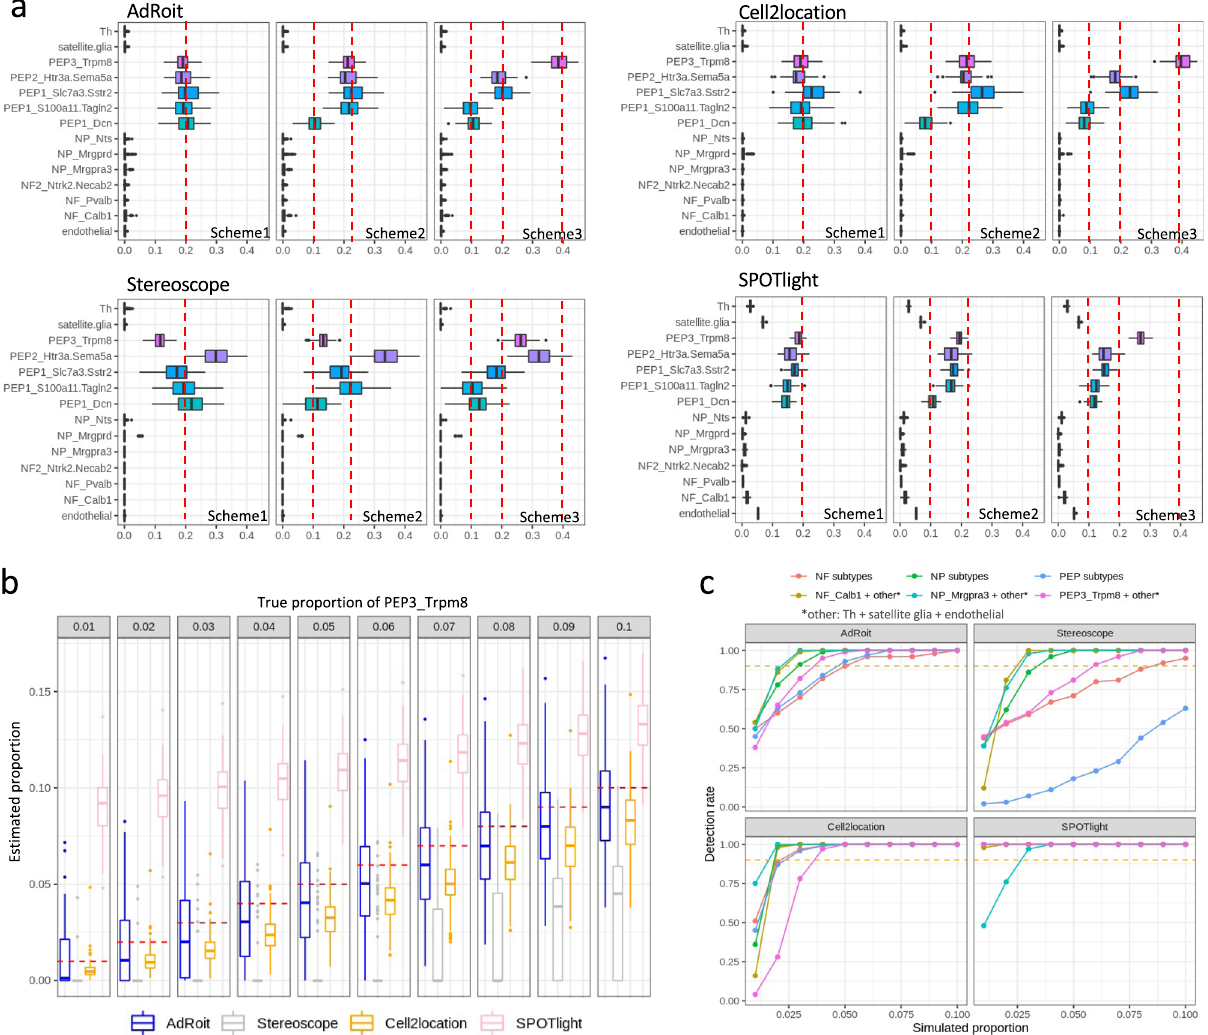
Fig. 5 AdRoit shows a good accuracy and sensitivity in deconvoluting spatial spots simulated from dorsal root ganglion cells. a Estimations from AdRoit, Cell2location, Stereoscope, and SPOTlight on simulated spatial spots that contain 5 PEP neuron subtypes. True mixing proportions are denoted by the red dashed lines. Three schemes are presented: (1) the proportions of 5 PEP cell types are the same and equal to 0.2; 2) PEP1_ Dcn is 0.1 and the other 4 are 0.225; 3) PEP1_ Dcn and PEP1_ S100a11.Tagln2 are 0.1, PEP1_ Slc7a3.Sstr2 and PEP2_ Htr3a.Sema5a 0.2 are 0.2, and PEP3_ Trpm8 is 0.4. The boxplots were derived from n = 100 independent simulations. b The performance of AdRoit, Cell2location, Stereoscope, and SPOTlight in estimating rare cell populations in the spatial spots. The spots contain a mixture of three PEP cell subtypes (i.e., PEP1_ Slc7a3.Sstr2 , PEP2_ Htr3a.Sema5a , and PEP3_ Trpm8 ), with the percent of PEP3_ Trpm8 ranging from 1 to 10% and the other two cell types sharing the remaining proportion equally. The boxplots were drawn upon n = 100 independent simulations. c Compare the rate of detecting rare cells in simulated spots. An inferred percent greater than 0.5% is deemed as a positive detection. Six sets of cell mixtures are employed: NF_ Calb1 with NF_ Pvalb and NF2_ Ntrk2.Necab2 (NF subtypes), NP_ Mrgpra3 with NP_ Mrgprd and NP_ Nts (NP subtypes), PEP3_ Trpm8 with PEP1_ Slc7a3.Sstr2 and PEP2_ Htr3a.Sema5a (PEP subtypes), NF_ Calb1 with Th, satellite glia and endothelial (NF_ Calb1 + others), NP_ Mrgpra3 with Th, satellite glia and endothelial (NP_ Mrgpra3 + others), and PEP_ Trpm8 with Th, satellite glia and endothelial (PEP_ Trpm8 + others). In each set, the fi rst cell type listed is the target of detection and varies its percent from 1 to 10%. The rest cell types split the remaining proportion evenly. The red dashed lines mark the detection rate of 90%. The rates were computed based on n = 100 independent simulations. Bars in the boxplots mark the 1.5× interquartile